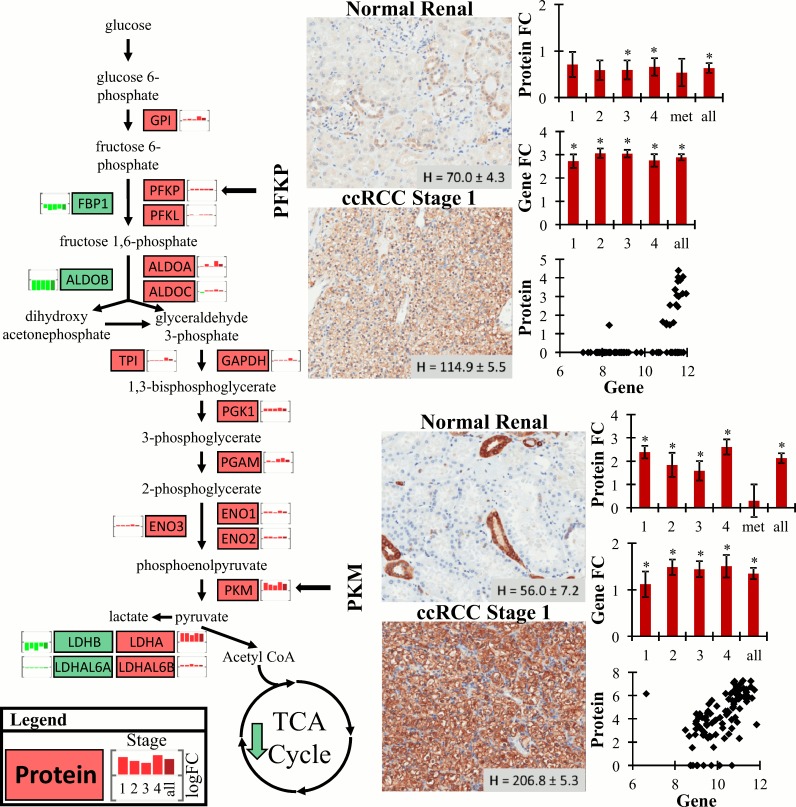
Protein abundance changes with stage in the glycolysis pathway.Using only proteins that were differentially abundant at each stage, the glycolysis pathway was interrogated. Directionality of change is indicated by red (increased in tumor) or green (decreased in tumor) and the small bar graph next to each protein symbol in the pathway is protein fold-change (tumor/normal) at stage I, II, III, IV and then all stages (from left to right). Levels of two proteins, PFKP and PKM, were confirmed using IHC staining of stage I ccRCC tissue (other stages were not evaluated by IHC). A representative IHC image is shown for PFKP and PKM along with average staining intensity (H value) ± standard error of a stage I ccRCC TMA. For both PFKP and PKM the average log2 fold-change (FC) levels ± standard error for protein abundance (stage I-IV and metastasis tissue) and gene expression (stage I-IV) are displayed as bar graphs (‘*’ indicates significance, BH adjusted p < 0.05). Below each pair of bar graphs is a scatter plot of log2 normalized spectral counts (protein) versus RMA normalized array gene expression data from the 94 tissues with proteomic and transcriptomic data.